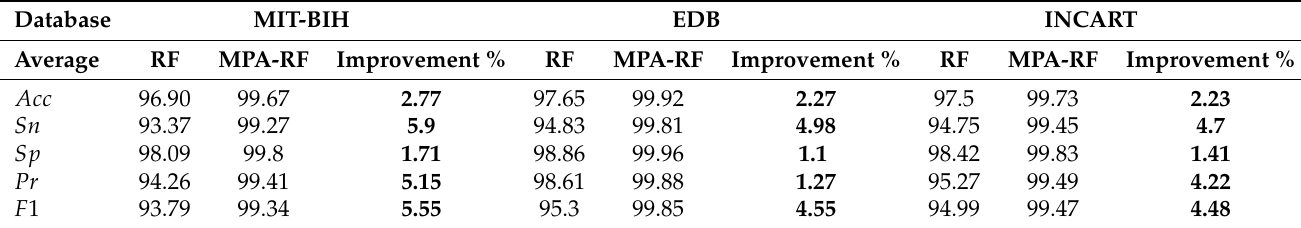
Table 10. The performance comparison of the RF and its optimized version, the MPA-RF.